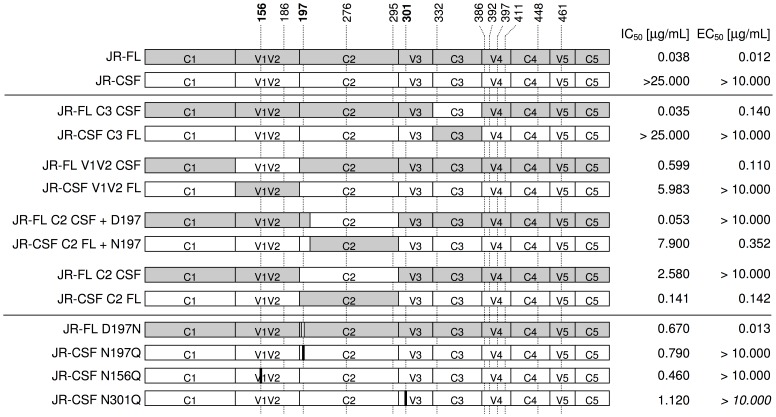
Neutralization potency (IC50) and binding to gp120 (EC50) JR-FL/JR-CSF chimeras as well as NGS mutants.Neutralization potency was assed using the TZM-bl assay format. The JR-FL sequence is represented in grey, JR-CSF in white, whereas residues that do not naturally occur in either are depicted black. Swapping of the V1V2 as well as the C2 domain caused major changes in sensitivity to 1F7. Of note, while a glycosylation at position 197 seems to render the virus more neutralization-sensitive, a swap of the more carboxy-terminal part of C2 was additionally required in order to impact antibody binding to detergent-solubilized gp120. EC50 data are representative of at least 3 titrations of each MAb against the respective JR-FL/JR-CSF chimeras.